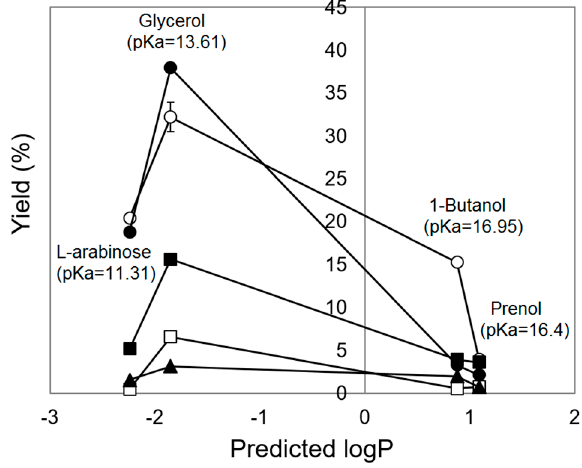
Figure 5. Effect of acceptor polarity on the transesterification yield of selected FAEs representing different phylogenetic subfamilies. Black circle: C1FaeA1 (SF5); white circle: Fae125 (SF5); black square: C1FaeB2 (SF6); white square: Fae68 (SF1); black triangle: AnFaeA (SF7). Reaction conditions: 50 mM VFA, 50 mM acceptor, 0.1 mg protein mL − 1 , 19.8:74.7:5.5 v / v / v n -hexane: t -butanol: buffer, 45 ◦ C, no agitation, 8 h of incubation. The error bars represent the standard deviation between two duplicate.